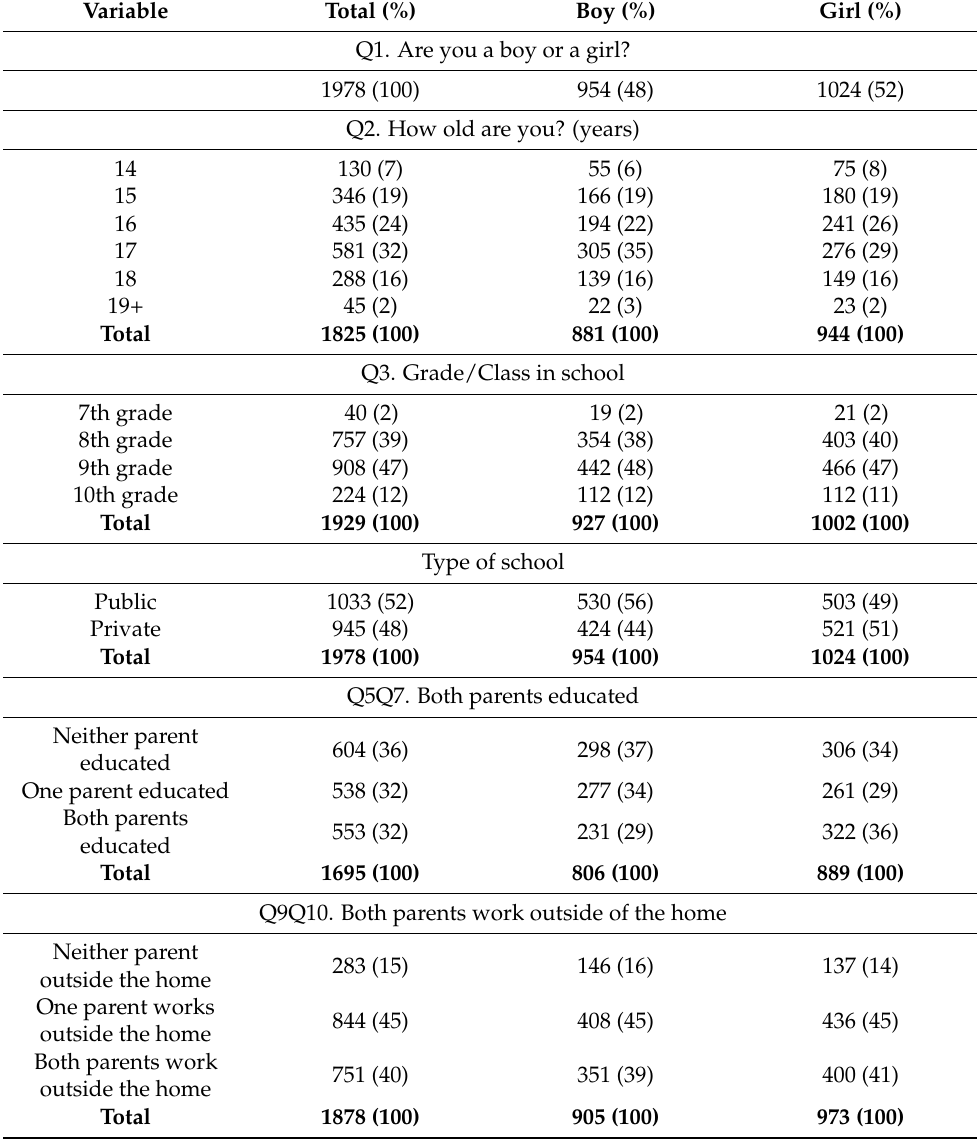
Table 4. Frequency table of selected socioeconomic and demographic variables, by